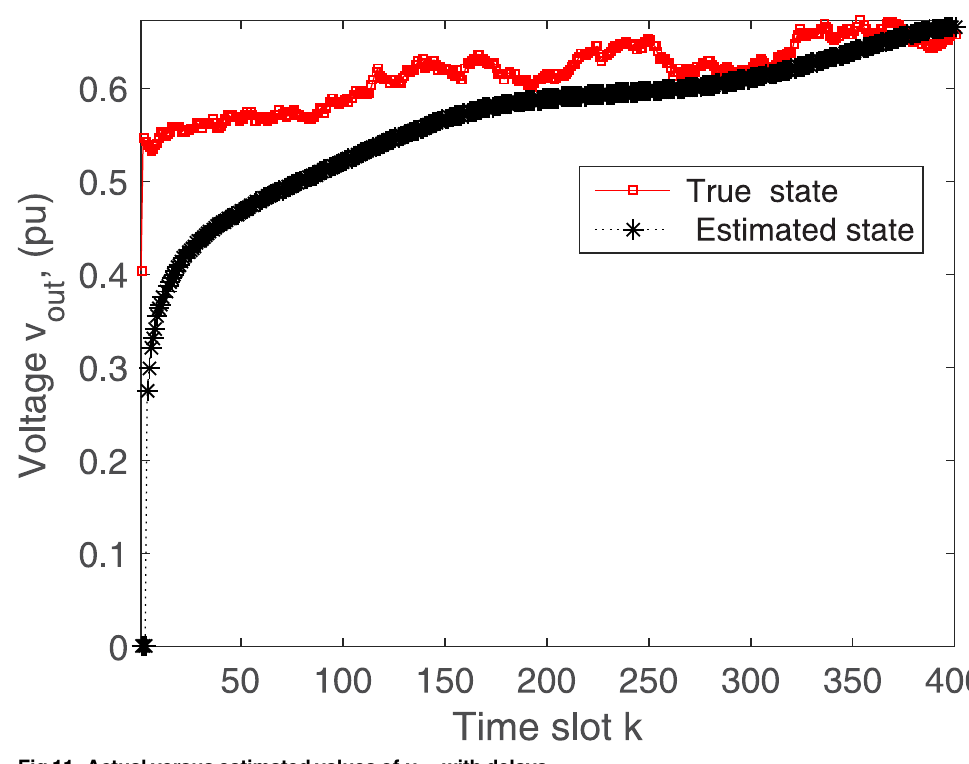
Fig 11. Actual versus estimatedvalues of v out with